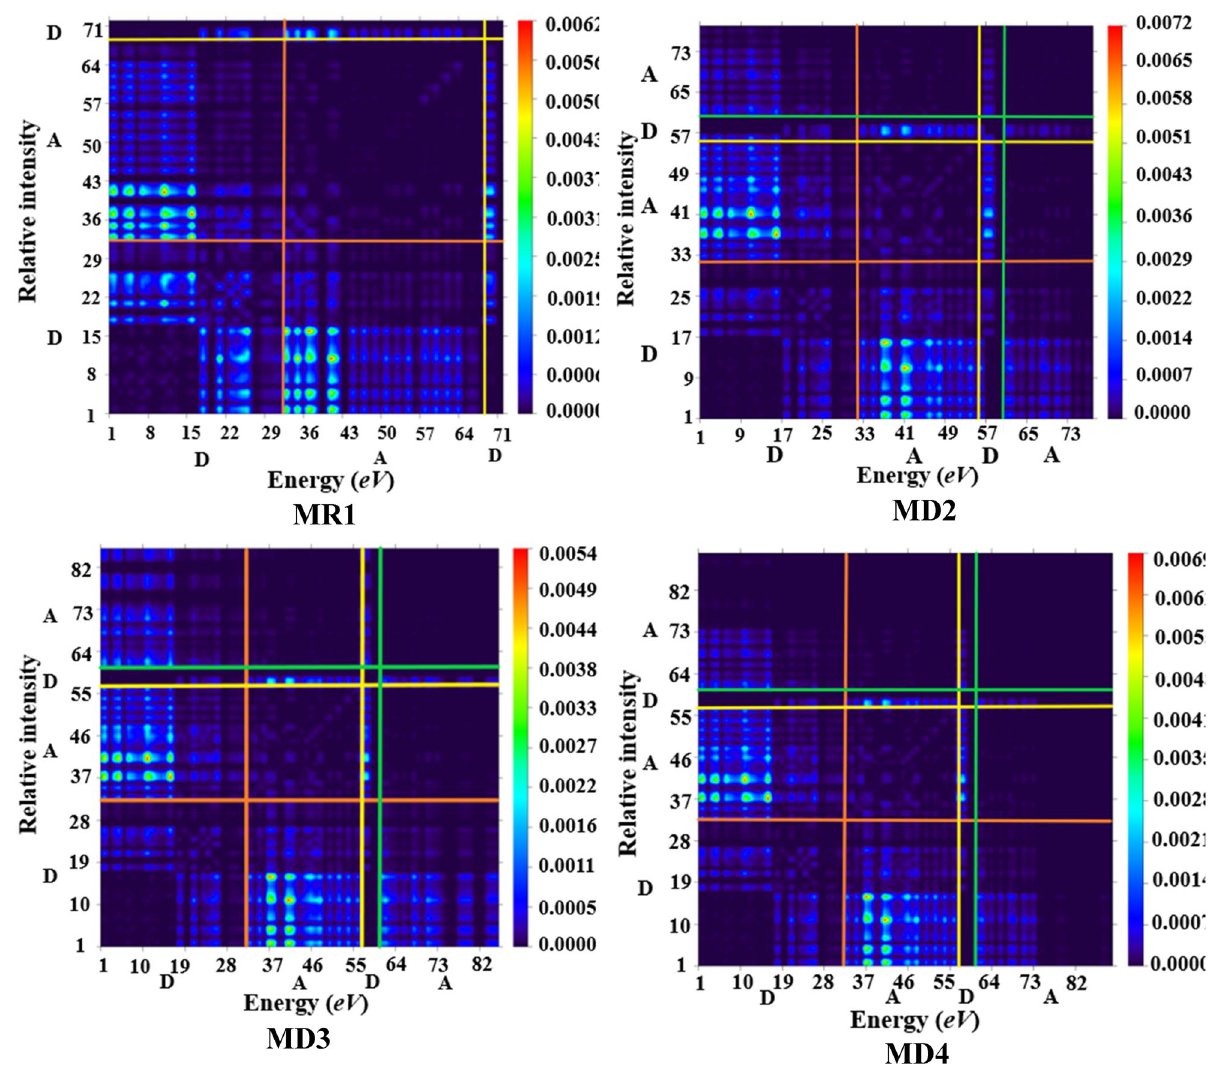
Figure 8. TDM for the entitled compounds ( MR1 and MD2–MD8 ). These were drawn with the help of Multiwfn 3.7sofware (http:// sober eva. com/ multi wfn/). All out put files of designed compounds were accomplished by Gaussian 09 version D.01 (https:// gauss ian. com/ g09ci